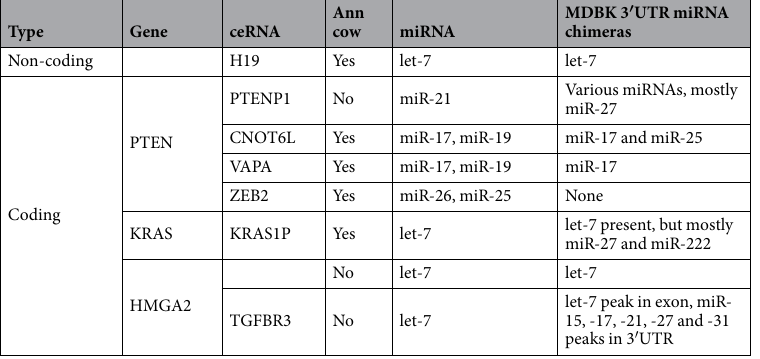
Table 2. Previously described ceRNAs relating to the 50 most abundant miRNAs in MDBK cells. Definitions of previously described ceRNAs in human or mouse were obtained from ref.